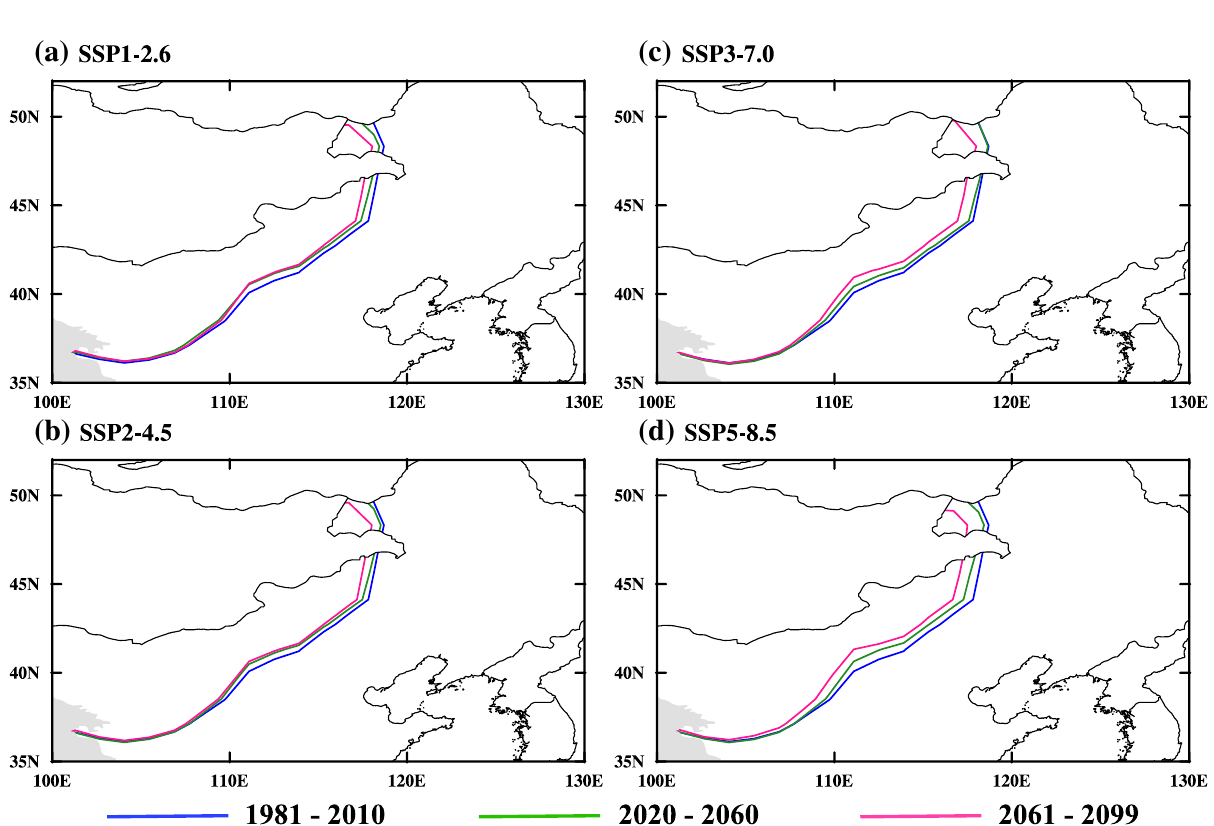
Figure 2. Climatological distribution of the EASM northern boundary over eastern China projected by CMIP6 MME. The solid lines in ( a – d ) indicate the boundaries for 2020–2060 (near-term) and 2061–2099 (late-term) in SSP1-2.6 ( a ), SSP2-4.5 ( b ), SSP3-7.0 ( c ), and SSP5-8.5 ( d ) during the twenty-first century compared to the present day. Maps were generated using the NCAR Command Language (The NCAR Command Language (Version 6.6.2) [Software]. (2019). Boulder, Colorado: UCAR/NCAR/CISL/TDD. https:// www. ncl. ucar. edu/ Downl